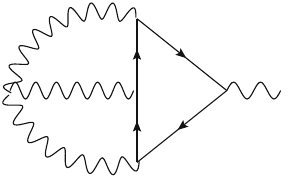
Fig. 1 The 1 / n 2 diagram σ 3 (cid:7)→ σ∂ 2 σ which could contribute to the element γ 21 of the mixing matrix